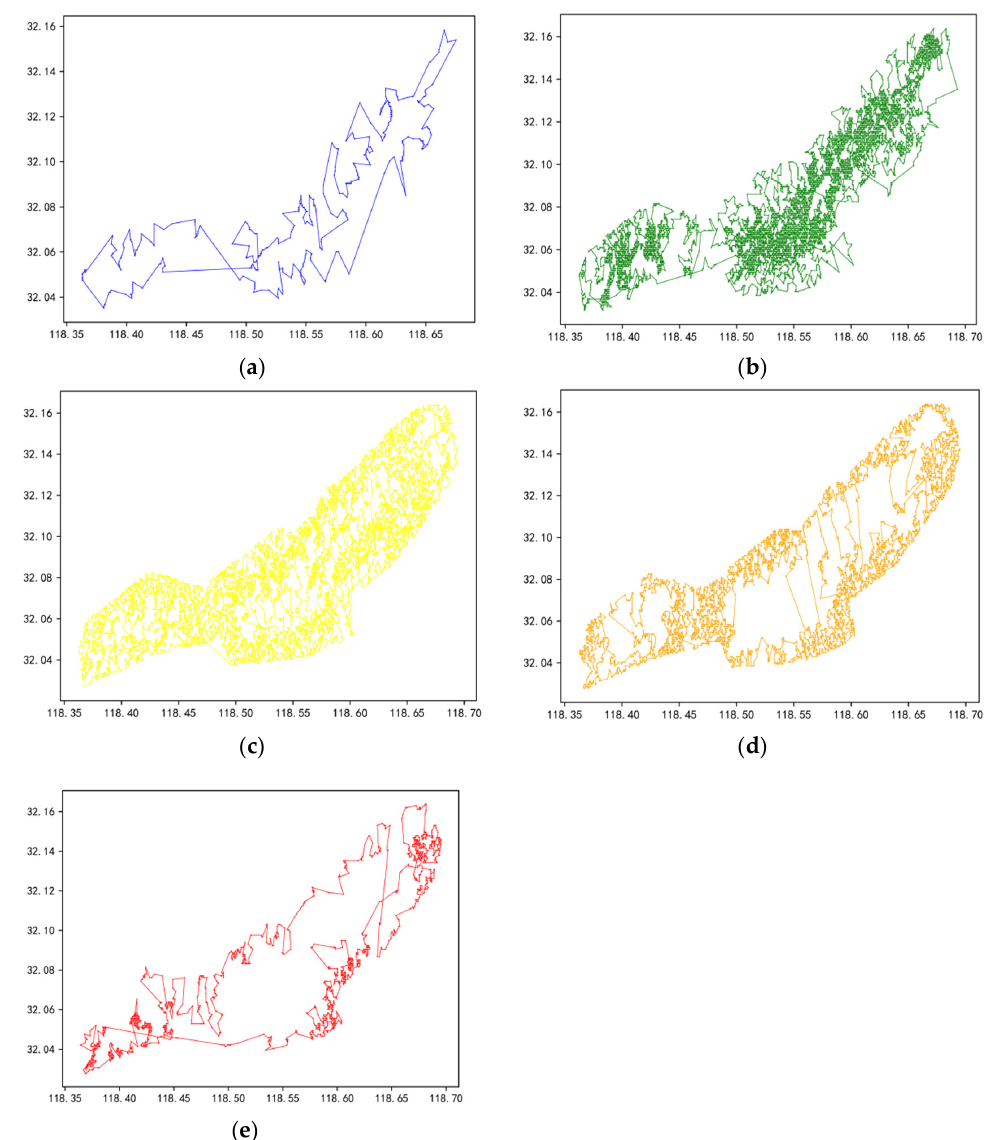
Figure 3. Extracted coordinates for patrolling: ( a ) very-low-risk area; ( b ) low-risk area; ( c ) moderate- risk area; ( d ) high-risk area; ( e ) very-high-risk area.